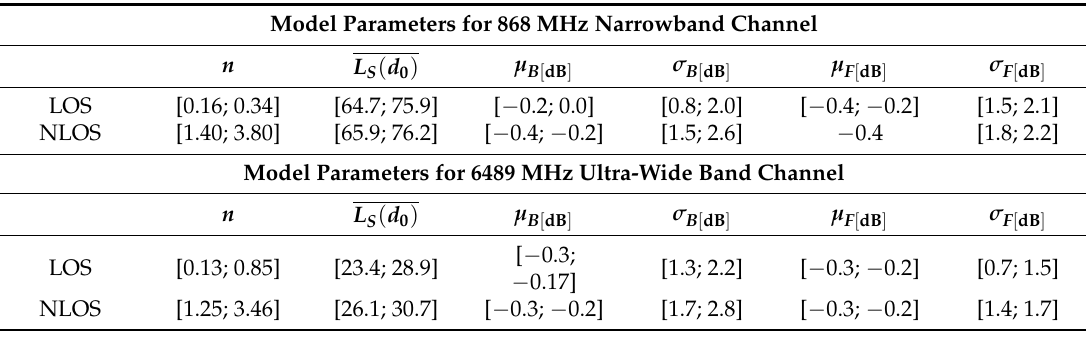
Table 1. Parameters of the system loss model for off-body communication in the ferryboat environment